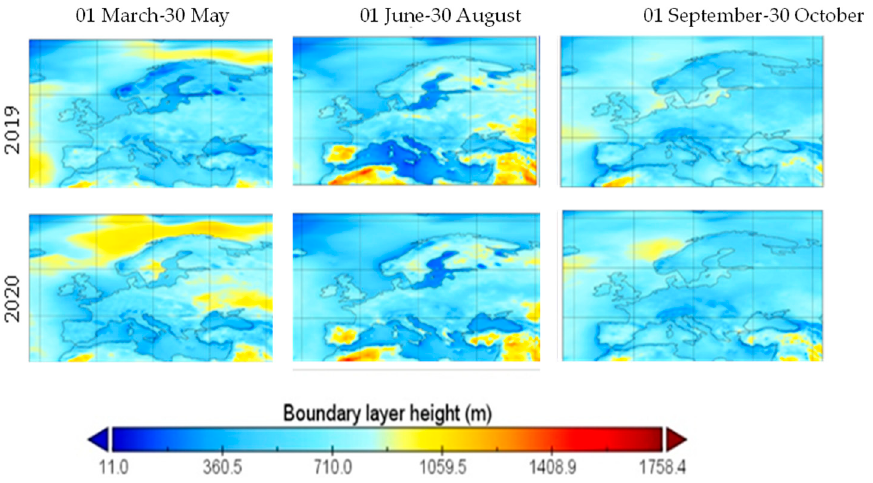
Figure 8. Average of the boundary layer height over Europe in three periods, 2019 and 2020.